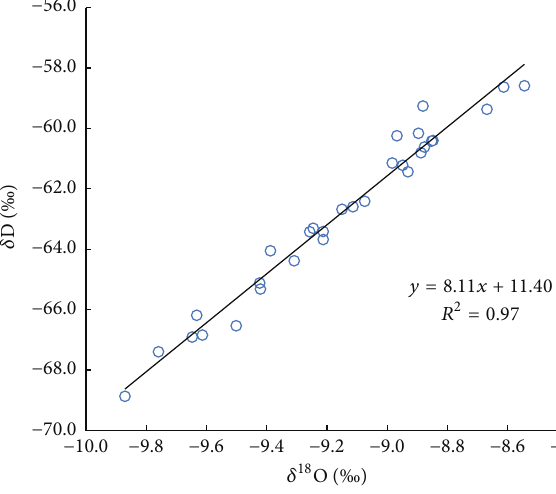
Figure 4: Stable isotope ( 𝛿 D and 𝛿 18 O) compositions of river